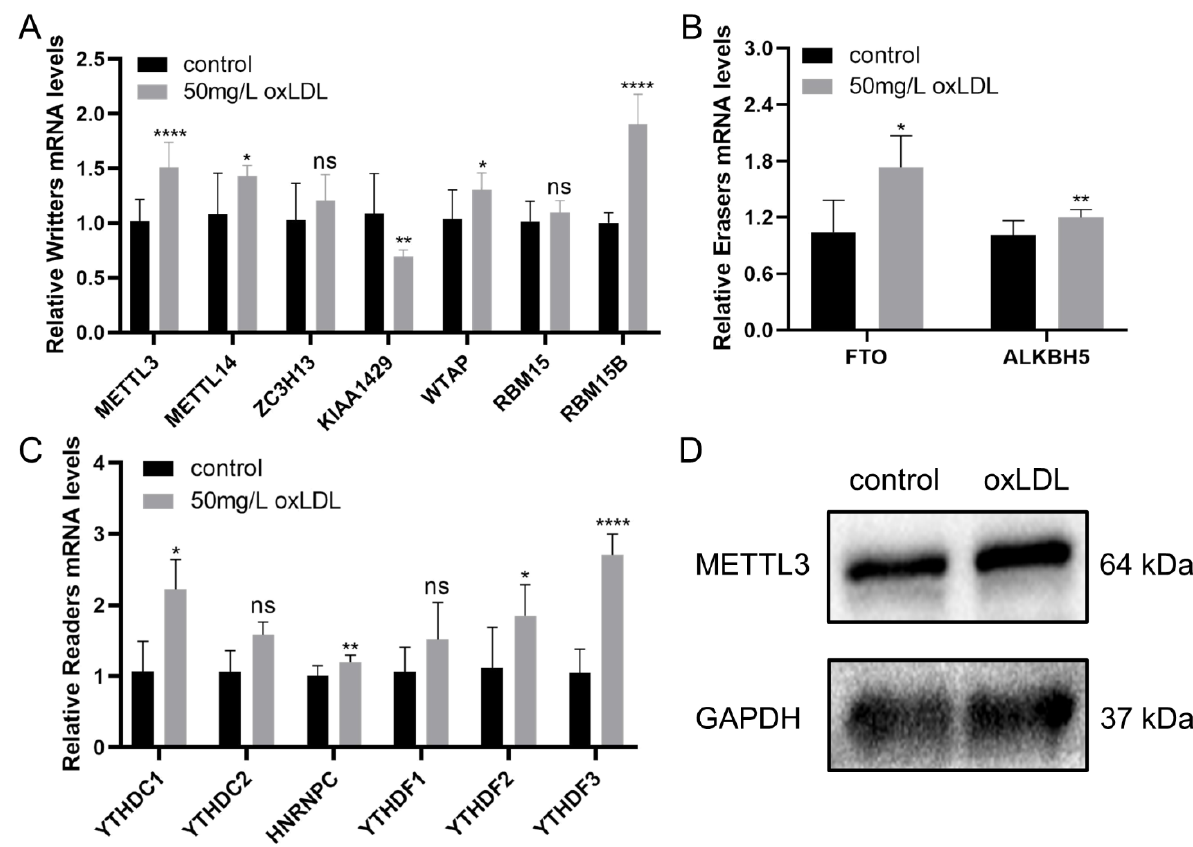
Figure 7. The expression of methylases in HCASMCs: ( A ) The expression of writer methylases by qRT-PCR. ( B ) The expression of eraser methylases by qRT-PCR. ( C ) The expression of reader methylases by qRT-PCR. ( D ) The expression of METTL3 by WB. * p < 0.05, ** p < 0.01, **** p <